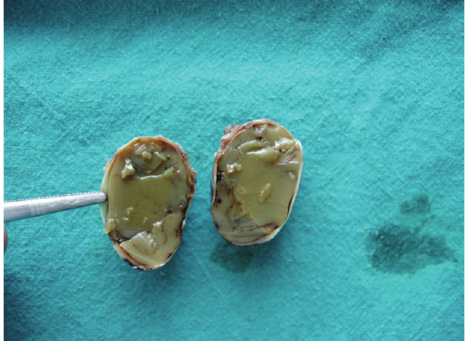
Figure 11: Sectioned gross specimen shows solidified cheese like material surrounded by a soft